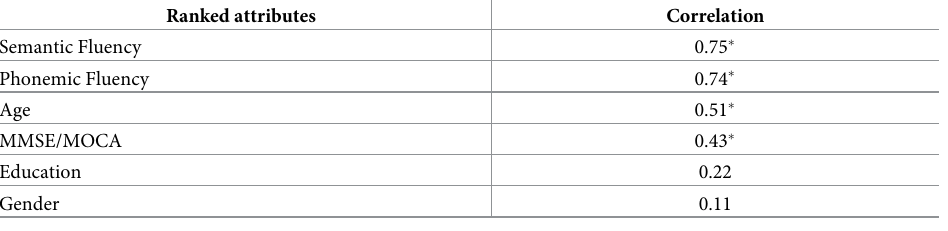
Table 3. Correlation analysis between Alternate Fluency test score and other neuropsychological scores and demographic